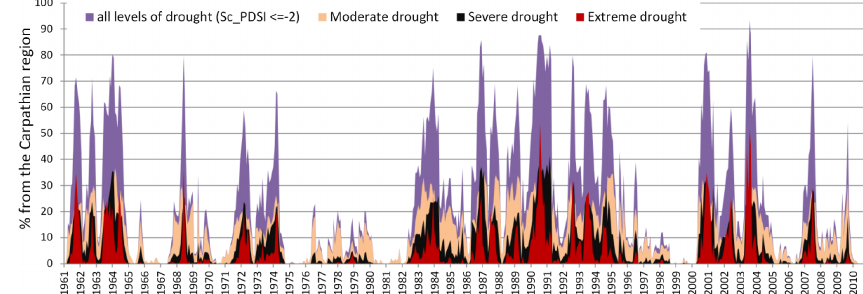
Figure 4. Incidence (% surface of the region) of different severity levels of drought per